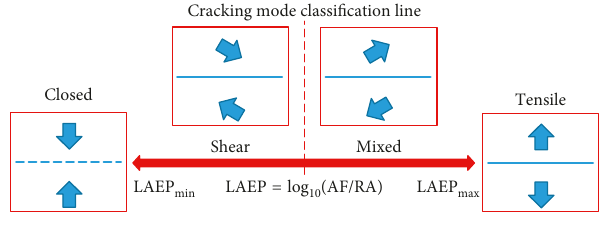
Figure 2: The definition of the parameter